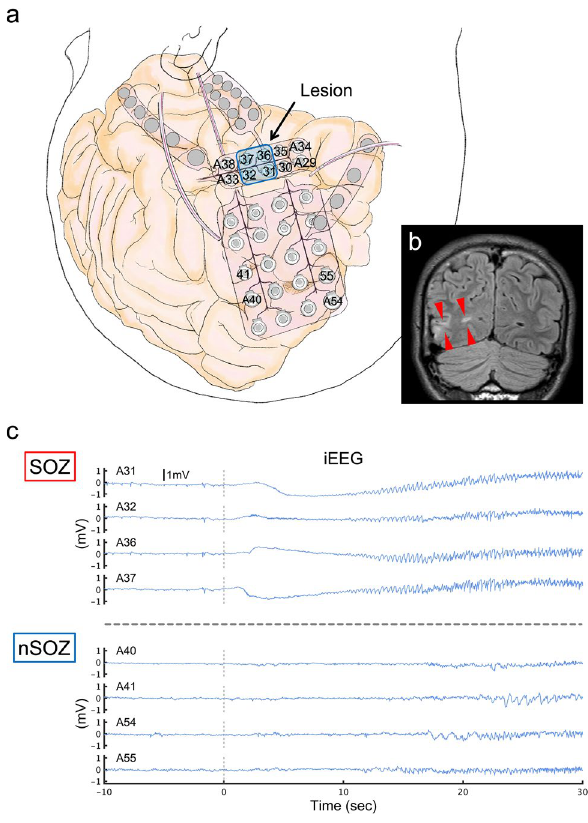
Figure 7. Contacts related to SOZ and nSOZ (P5-S3). ( a ) Illustration of implanted electrodes and the brain are displayed. The numbers correspond to the contacts’ number. This illustration was drawn by Hiroaki Hashimoto using Procreate (Savage Interactive Pty Ltd, Hobart, Australia, https:// procr eate. art/ ipad). ( b ) The high-intensity lesion in the right occipital lobe is shown on the fluid-attenuated inversion recovery MRI (red wedge arrows). This lesion is indicated by the arrow in ( a ). ( c ) The SOZ contacts, which include A31, A32, A36, and A37, placed on the lesion initially show infraslow activity immediately after SO (0 s), followed by low-voltage fast waves. At that time, nSOZ contacts of A40, A41, A54, and A55 show no epileptic changes. The number of SOZ and nSOZ contacts are the